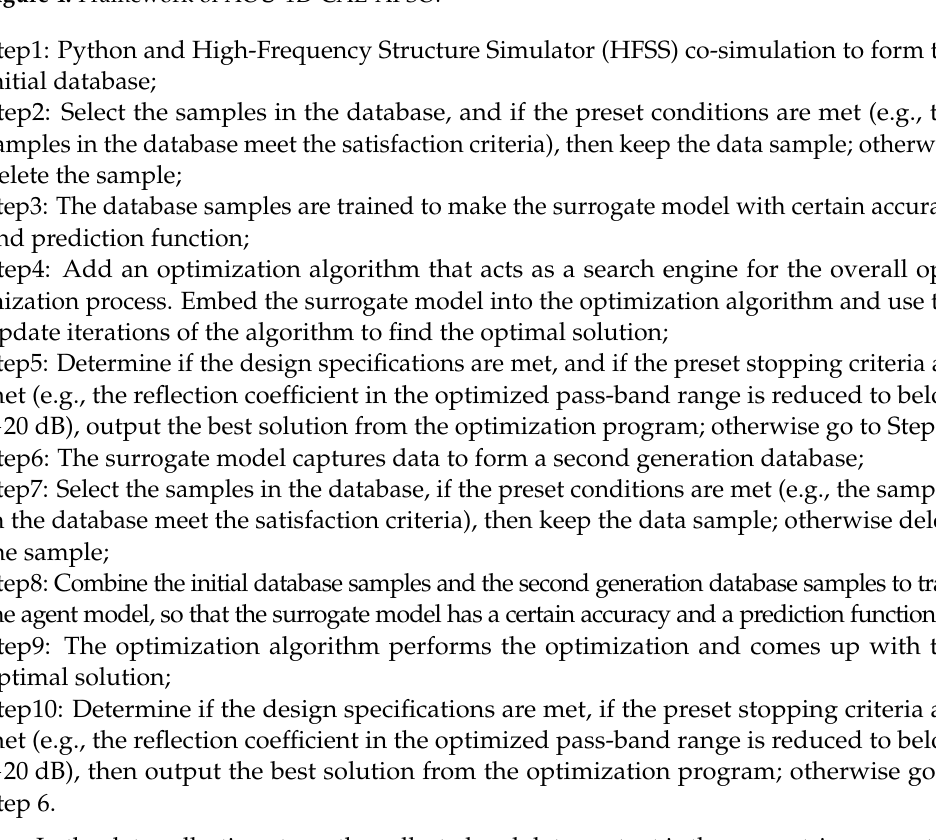
Figure 4. Framework of AOU-1D-CAE-APSO.